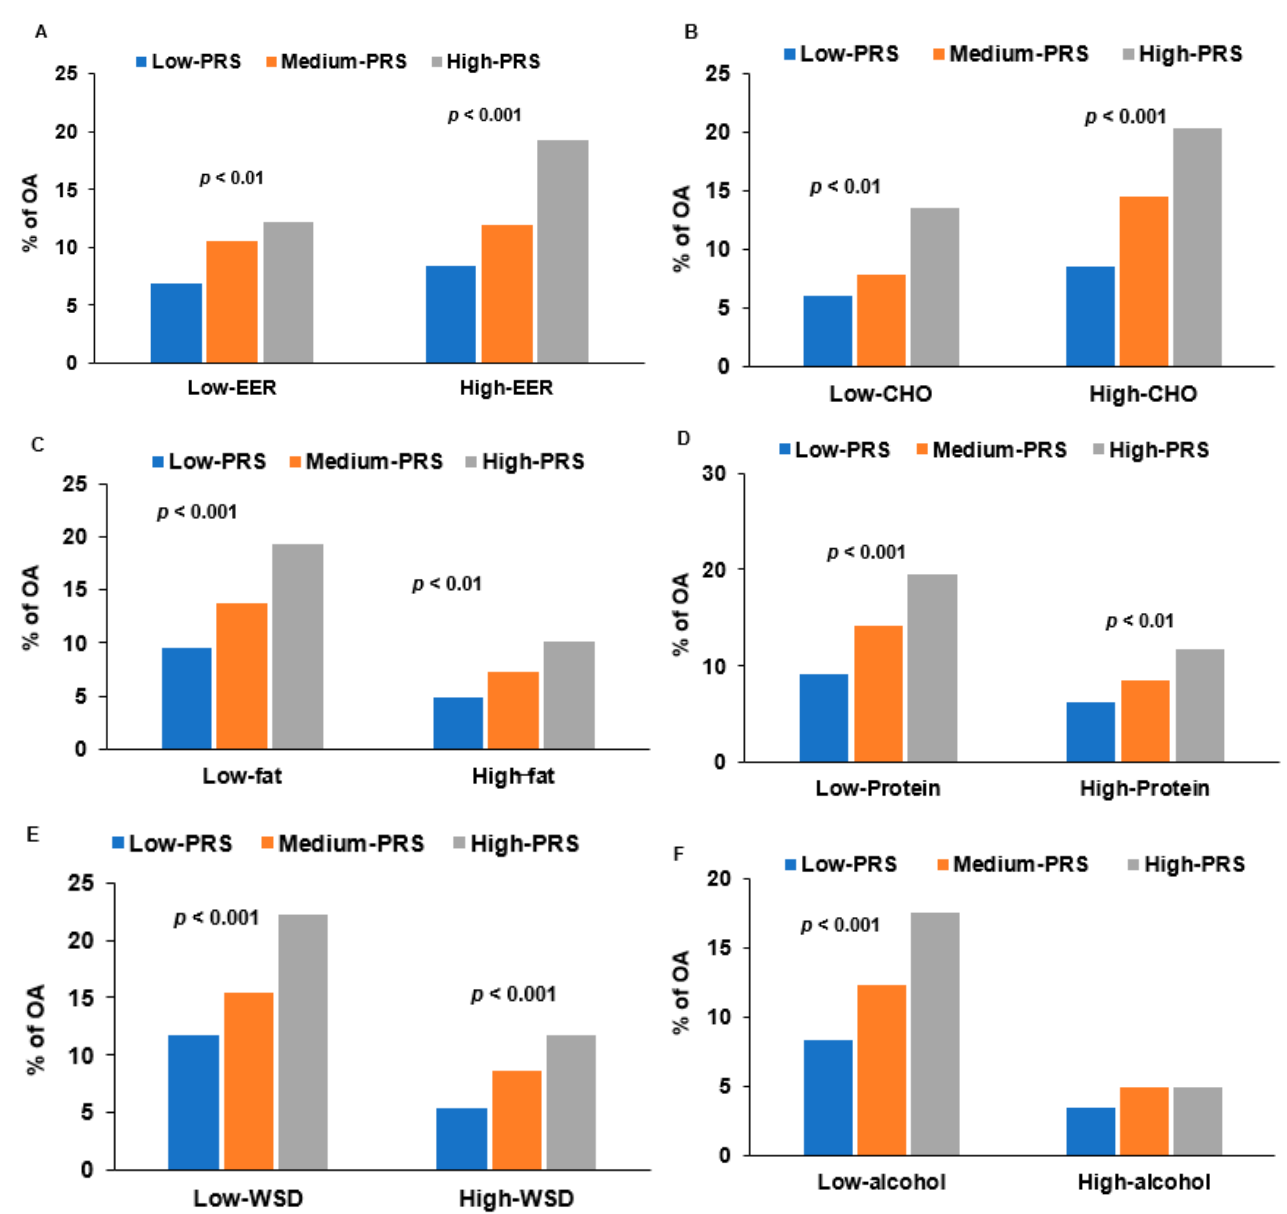
Figure 3. Interaction of nutrient intake with low, medium, or high polygenetic risk scores (PRS) from the 5-SNP model to influence osteoarthritis (OA) risk. ( A ). OA incidence (%) of the participants categorized by daily energy intake (cutoff value: estimated energy requirement (EER) according to age and genders). ( B ). OA incidence (%) of the participants categorized by carbohydrate (CHO) intake (cutoff value: 70 energy percent). ( C ). OA incidence (%) of the participants categorized by fat intake (cutoff value: 15 energy percent). ( D ). OA incidence (%) of the participants categorized by protein intake (cutoff value: 13 energy percent). ( E ). OA incidence (%) of the participants categorized by Western-style diet intake (cutoff value: 70th percentile). ( F ). OA incidence (%) of the participants by alcohol intake (cutoff value: 20 g alcohol/day). Covariates included age, gender, body mass index, OA duration, the status of smoking and drinking, levels of income and education, job, income, physical activity, energy intake, percent intake for carbohydrate and fat, and arthritis medication. Table 5. Adjusted odds ratios for osteoarthritis risk by polygenetic risk scores of the 5-SNP best model (PRS) for gene–gene interaction after covariate adjustments according to lifestyle patterns.